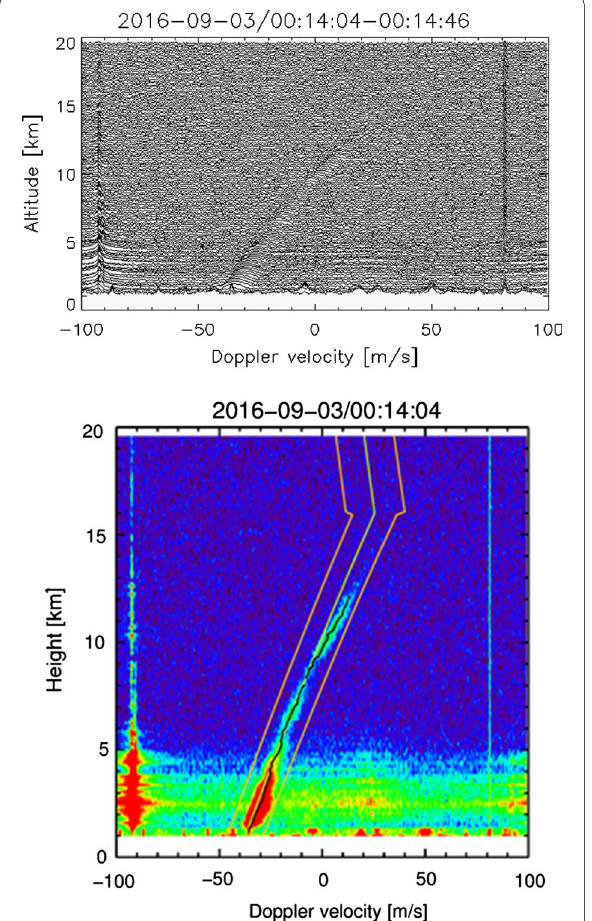
Fig. 6 Doppler spectra for RASS echoes observed at 00:14 LT on September 3, 2016, with the radar beam pointed at (90°, 13°). The horizontal axis shows the sound speed before correcting for the fre- quency shift (100 Hz) in the mixer. The top panel shows over plotting of the spectra, while the bottom panel shows the spectra as a con- tour plot. The black line indicates the fitted mean Doppler shift, while the yellow and orange lines are the standard temperature profile and ranges for removing outliers